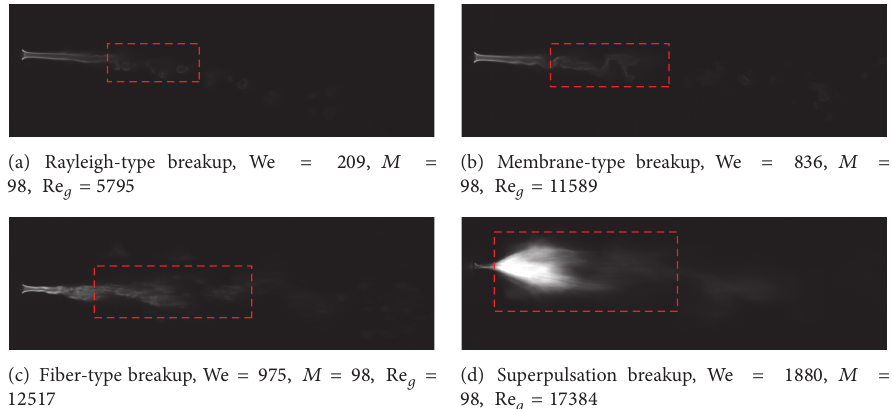
Figure 2: Representative photographs of four breakup regimes under hot conditions ((a) condition 5, (b) condition 12, (c) condition 33, and (d) condition 19).